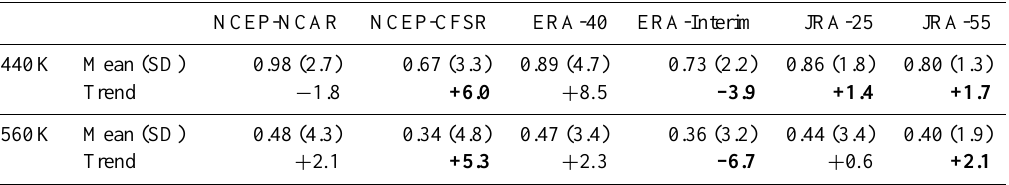
( + 0.6 to + 5.3 % decade − 1 ). The trend is negative only in ERA-Interim at both altitudes ( − 3.9 % decade − 1 at 440 K and − 6.7 % decade − 1 at 560 K). The estimated trends are